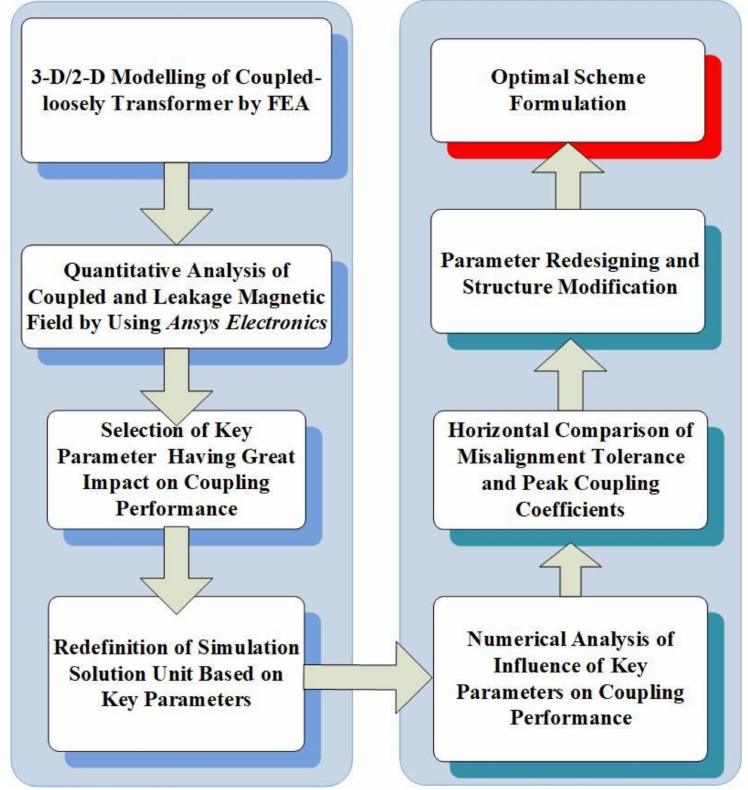
Figure 1. FEA-aided methodology of a loosely coupled